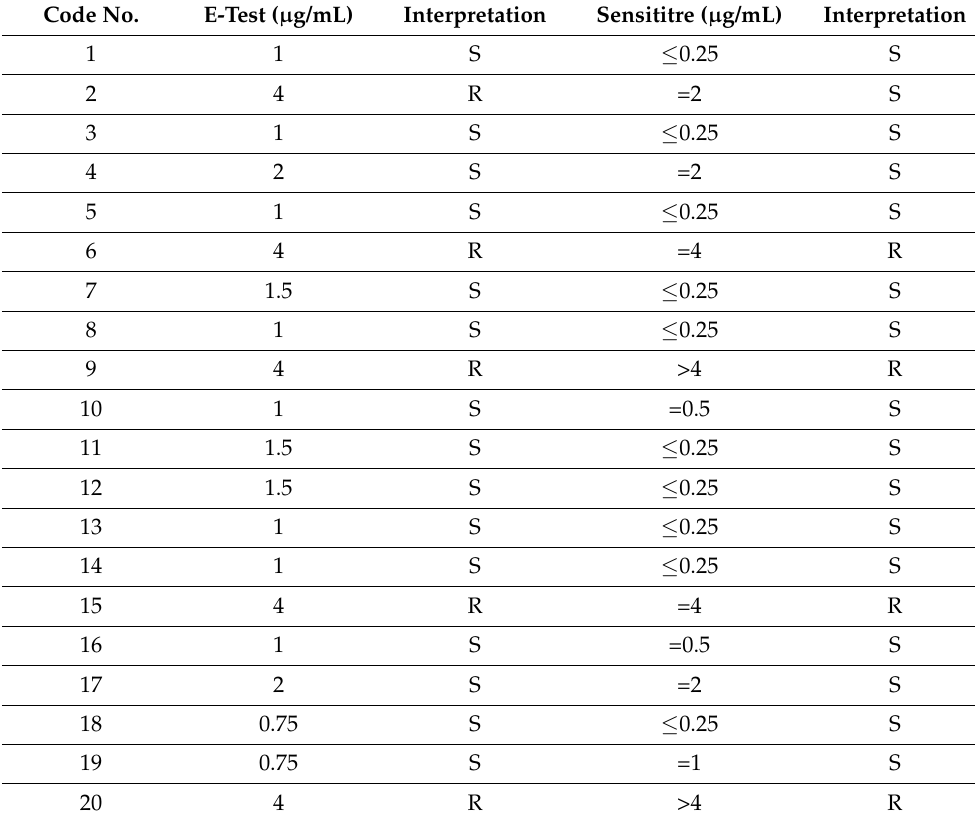
Table 3. Comparison of MIC values determined by Sensititre with those of E-Test. Code No.